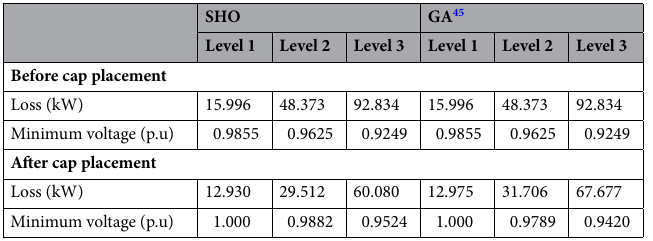
Table 13. Losses and minimum load voltage before and after the capacitor placement in the scenario of islanding at the different load levels with cosφ#1.